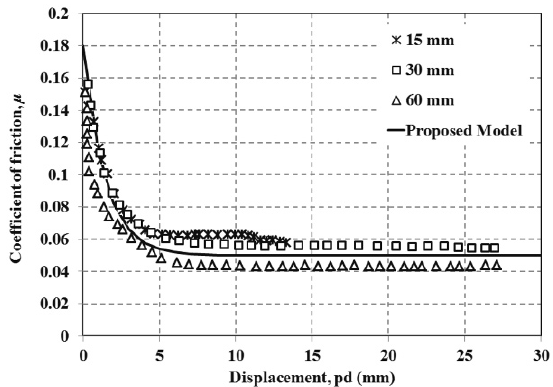
Figure 7. Coefficient of friction versus pullout displacement curves for hooked fiber and high strength